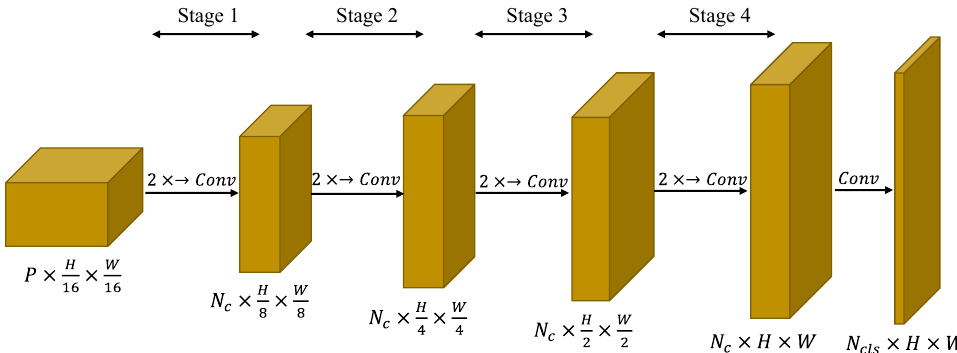
Figure 3. Overview of a decoder network. It consists of four upsampling